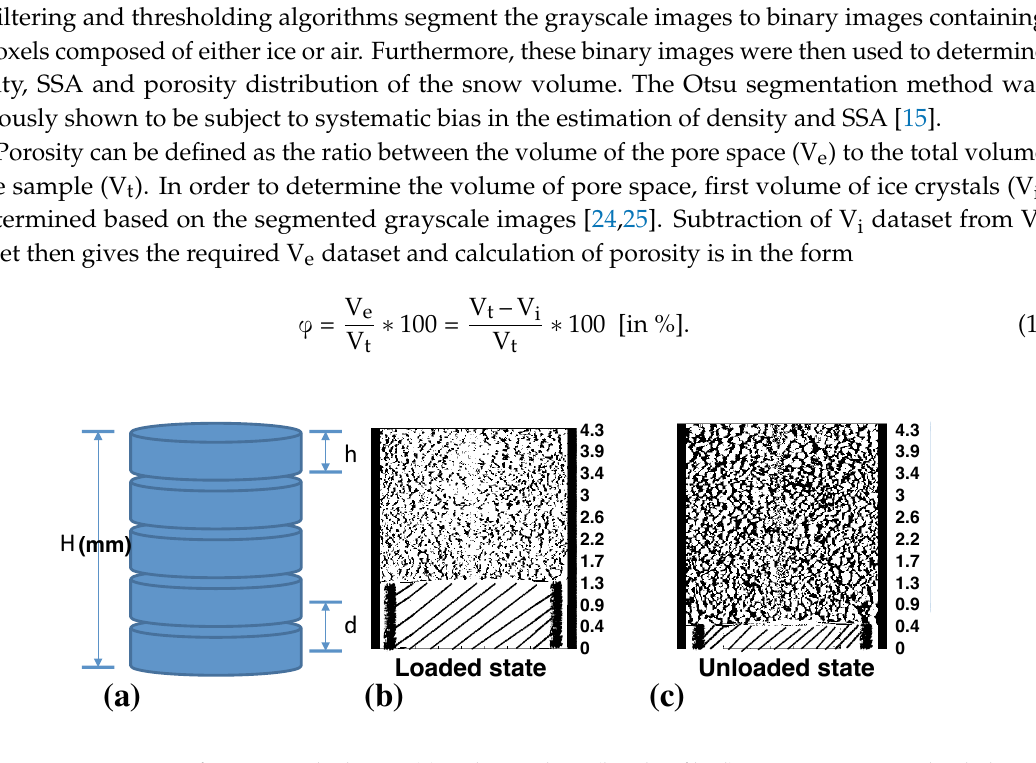
Figure 3. Concepts of porosity calculation: ( a ) in this study, H (height of bed) is 4.23 mm at an unloaded state while h (section height) and d (section distance) are 0.47 mm; ( b ) an example of loaded state; ( c ) an example of unloaded state. Note that area with lines in Figure 3b,c represents the moving punch and the gap between the moving punch and sample holder is 0.05